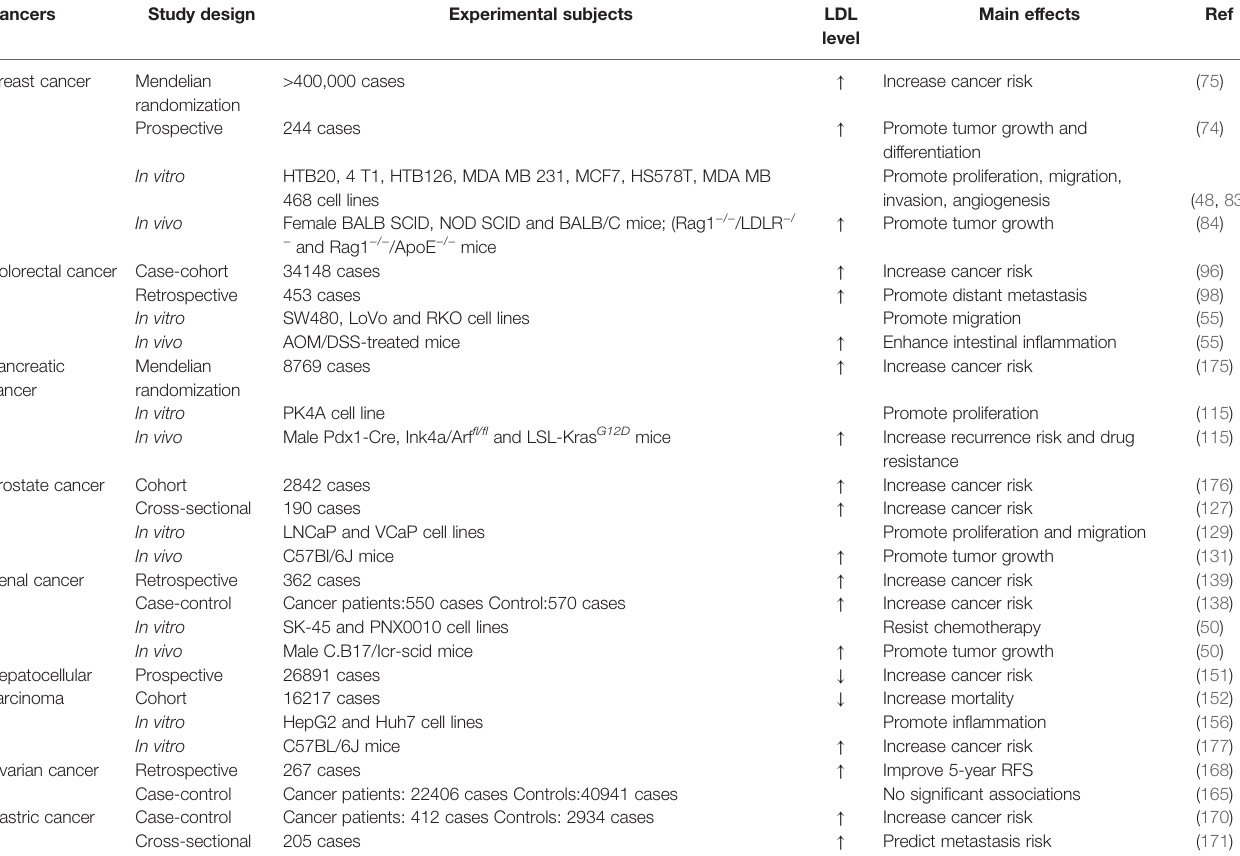
TABLE 1 | LDL levels and their possible effects on the development of selected types of cancer.